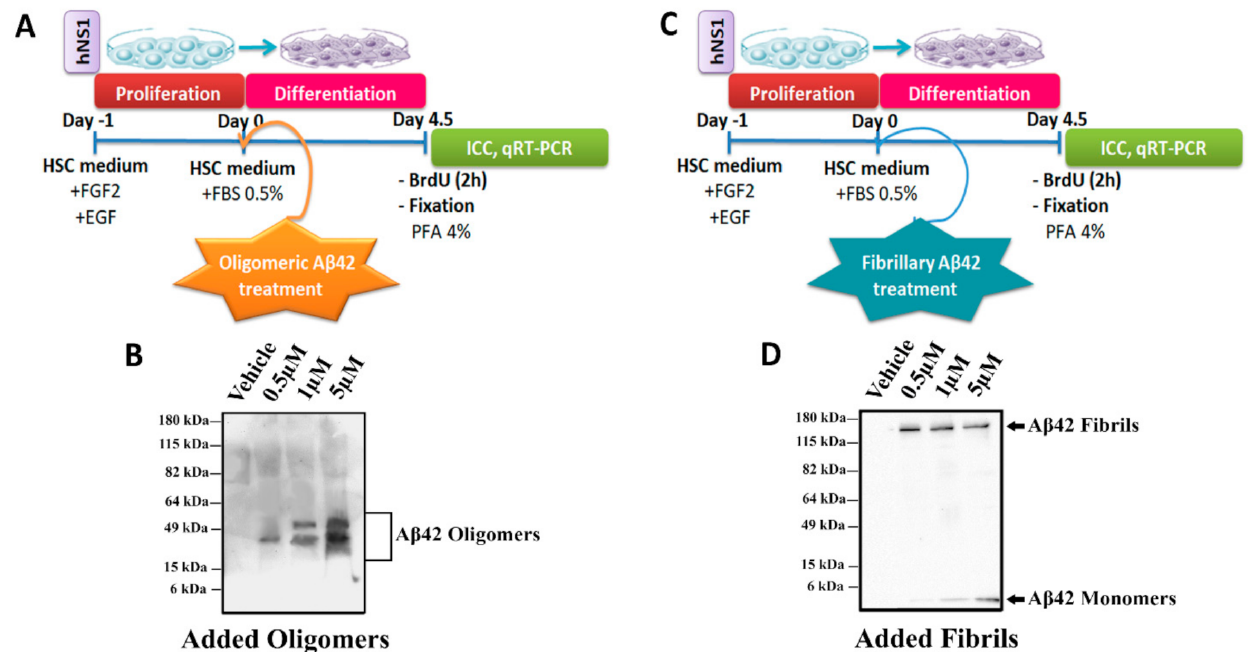
Figure 1. Schematic representation of the experiments and WB analysis. Schematic view of hNS1 cells’ differentiation protocol (See Materials and Methods section) for ( A ) A β 42 oligomers and ( C ) A β 42 fibrils. ( B ) Representative WB analysis of A β 42 forms (using 4G8 antibody) present in extracellular medium used for oligomeric A β 42 treatment. ( D ) Representative WB analysis of A β 42 forms (using 4G8 antibody) present in extracellular medium used for fibrillary A β 42